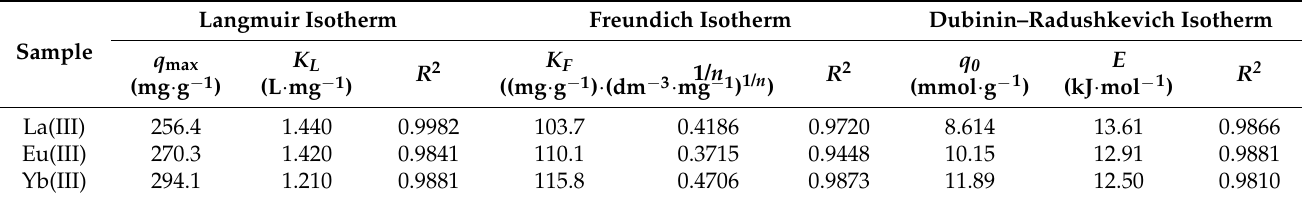
Table 3. Coefficient of Langmuir, Freundlich, and Dubinin–Radushkevich isotherms for REEs by EDTA–CS@ZIF-8.